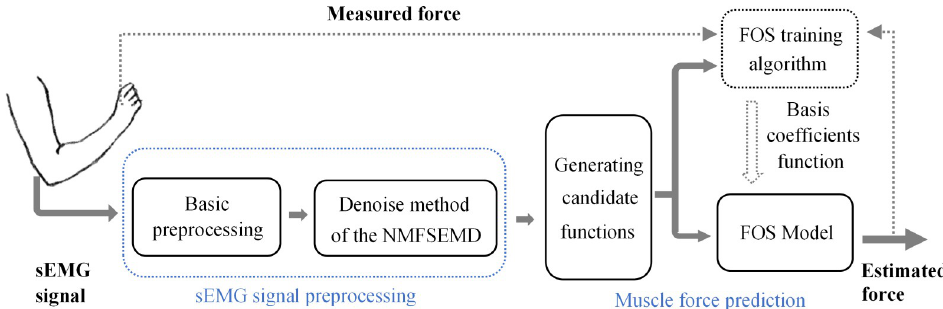
Fig 1. Computational flowchart of NMFSEMD denoising and FOS-based muscle force prediction using the denoised sEMG signals.